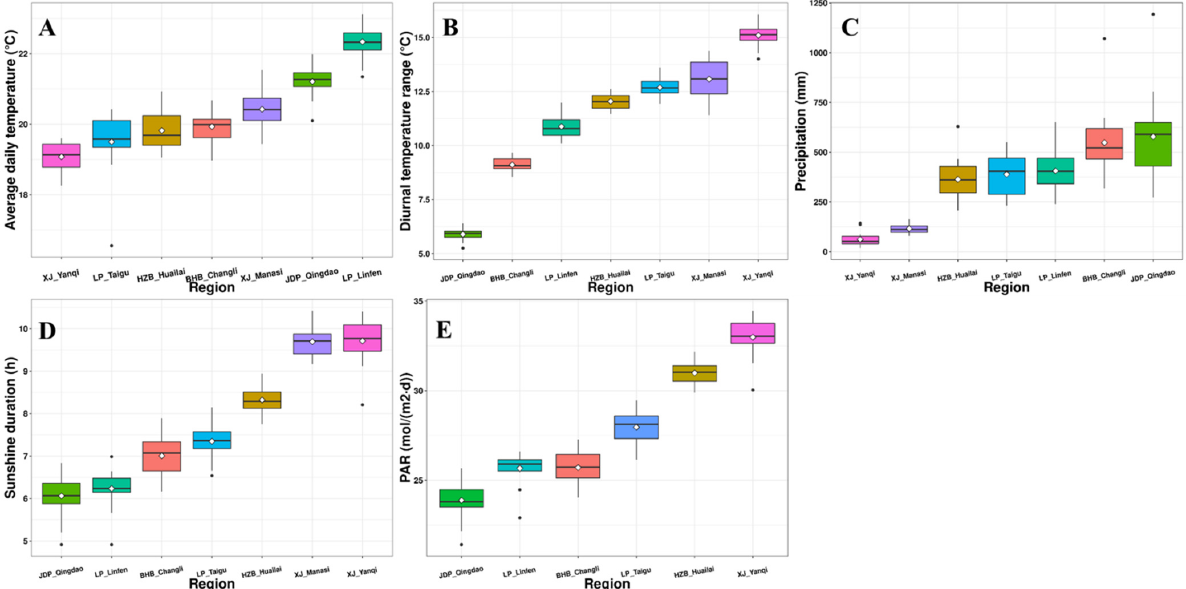
Figure 1. Climatic conditions of wine-producing sub-regions in China in this study. (A) Average daily temperature; (B) Diurnal temperature range; (C) Precipitation; (D) Sunshine duration; (E) PAR. The climatic condition of the Manasi region was based on Hutubi County. The PAR of the Taigu region was based on Taiyuan City.